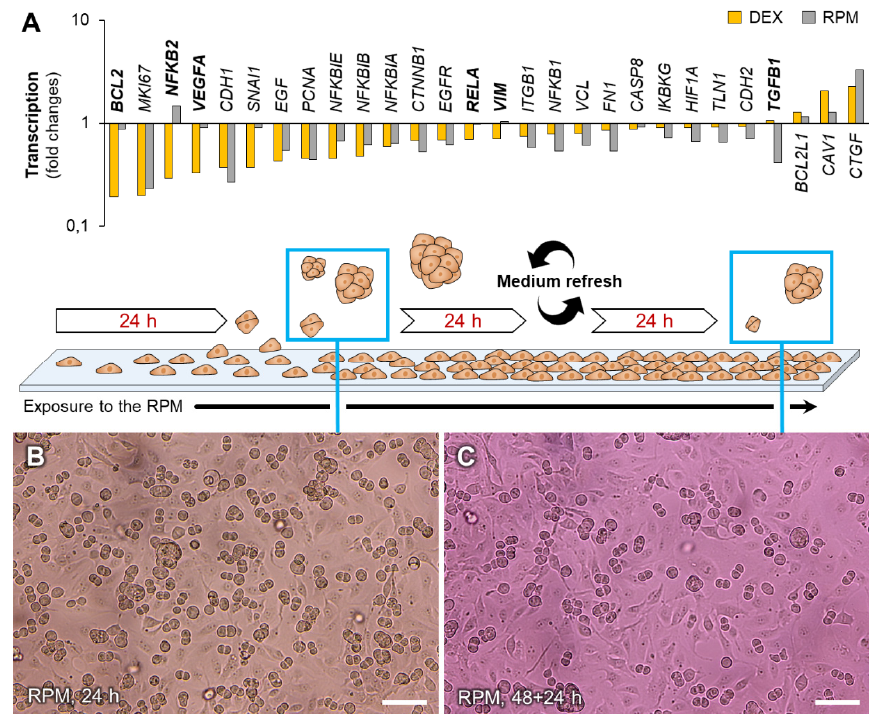
Figure 8. Spheroid formation capability of FTC-133 cells cultured on the RPM. ( A ) Comparison of transcription regulation patterns 4 h after DEX supplementation (yellow bars) and after a three-day RPM-exposure (grey bars). Bold gene symbols indicate fold changes >2.5 or regulation in opposite directions. ( B ) Cells 24 h after the RPM-experiment started; ( C ) Cells 24 h after an initial two-day RPM exposure. Medium was refreshed and spheroids were discarded after the first two days. Although many genes were similarly regulated after DEX supplementation and after a three-day-exposure to the RPM, in contrast to DEX treatment, cells did not lose the ability to form spheroids in µ g . Scale bars: 100 µ